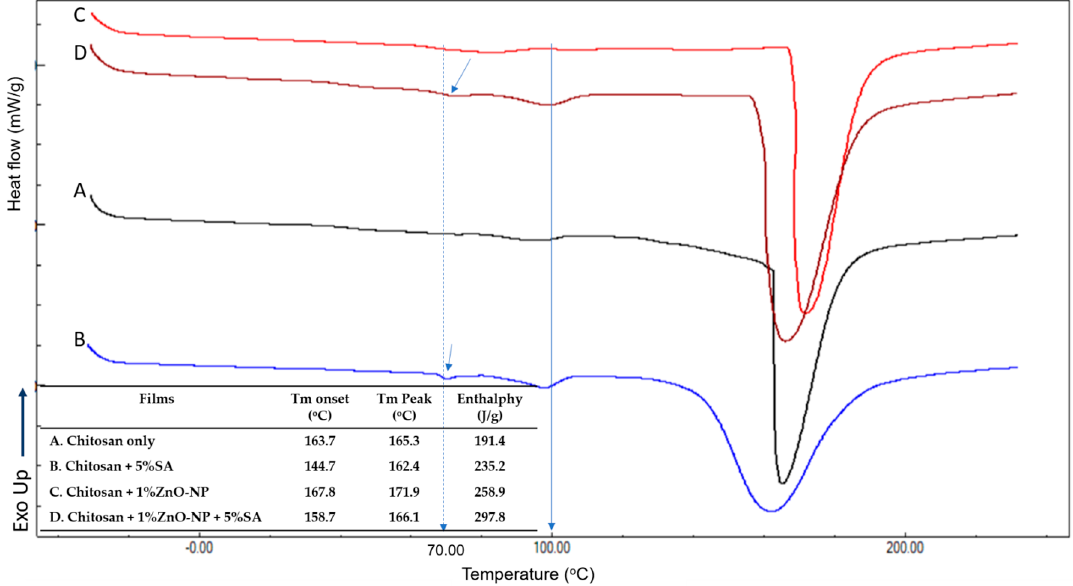
Figure 5. DSC thermogram of biohybrid-nanocomposite films: (A) chitosan only; (B) chitosan + 5%SA; (C) chitosan + 1%ZnO-NP; (D) chitosan + 1%ZnO-NPs+5%SA.